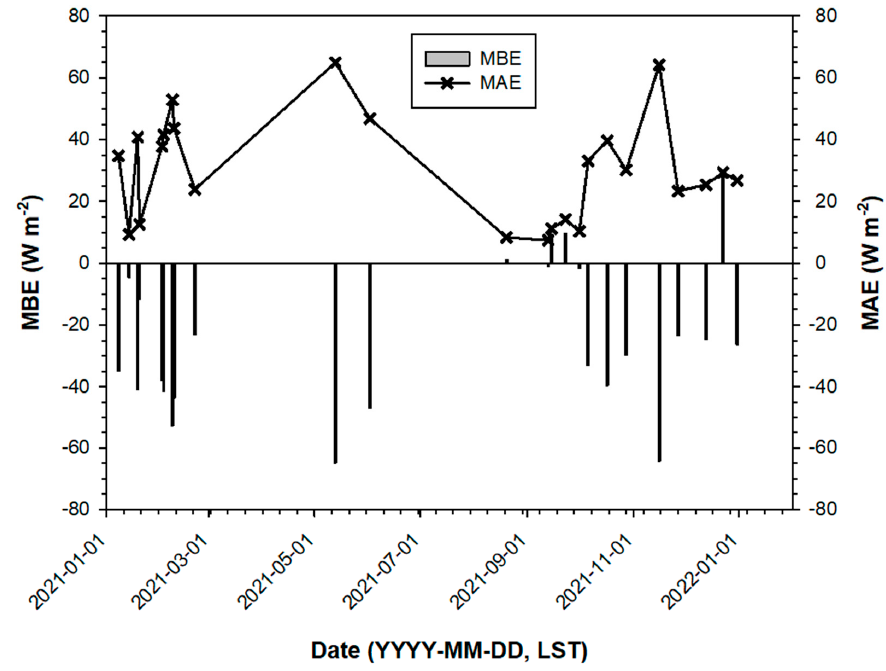
Figure 6. Monthly variation of mean bias error (MBE; bar) and mean absolute error (MAE; solid line with cross) between global horizontal irradiance (GHI) estimates from the control run and ground observations at the Korea Institute of Energy Research (KIER) station.